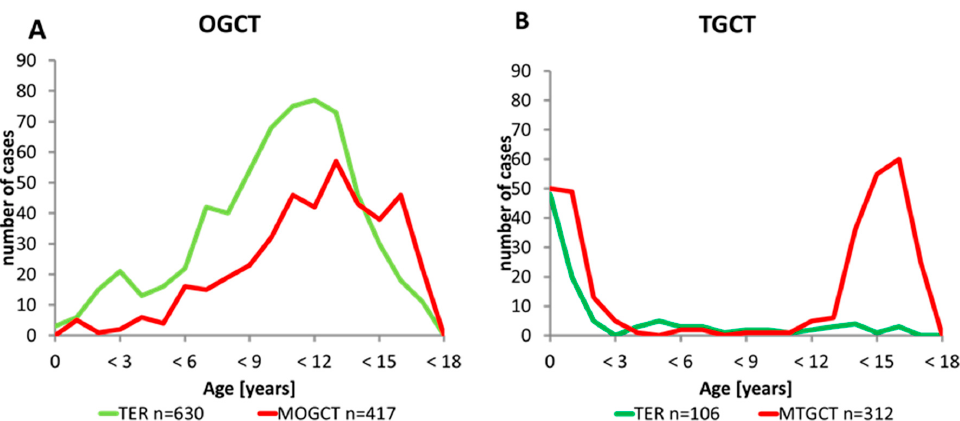
Figure 1. Occurrence of gonadal teratoma and malignant germ cell tumor with respect to sex and age. ( A ) Age distribution of 1047 patients with an ovarian germ cell tumor (OGCT) according to the histology groups: the green line represents the 630 teratomas (TER) and the red line represents the 417 malignant ovarian germ cell tumors (MOGCT) OGCT showed a continuously increasing incidence with a peak at approximately 12 years; ( B ) Age distribution of 418 patients with a testicular germ cell tumor (TGCT) according to the histology groups: the green line represents the 106 teratomas (TER) and the red line represents the 312 malignant testicular germ cell tumors (MTGCT). TGCT showed a bimodal age